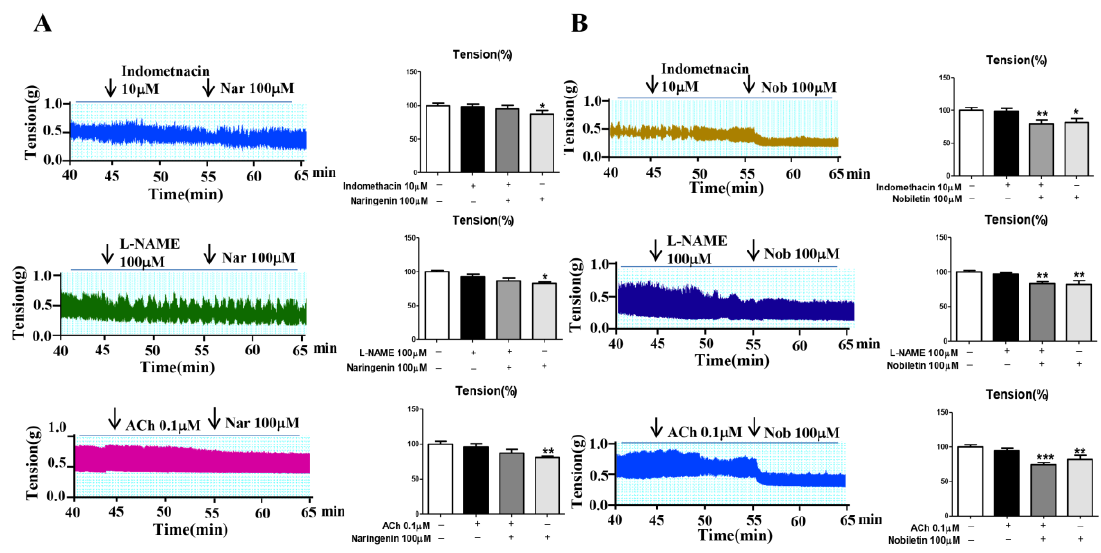
Figure 5. Inhibition mechanisms of ( A ) naringenin and ( B ) nobiletin on isolated jejunum contraction. Nar: naringenin; Nob: nobiletin; n = 6, * p < 0.05, ** p < 0.01, *** p < 0.001 vs. normal group. Data (mean ± SEM) were analyzed by ANOVA.